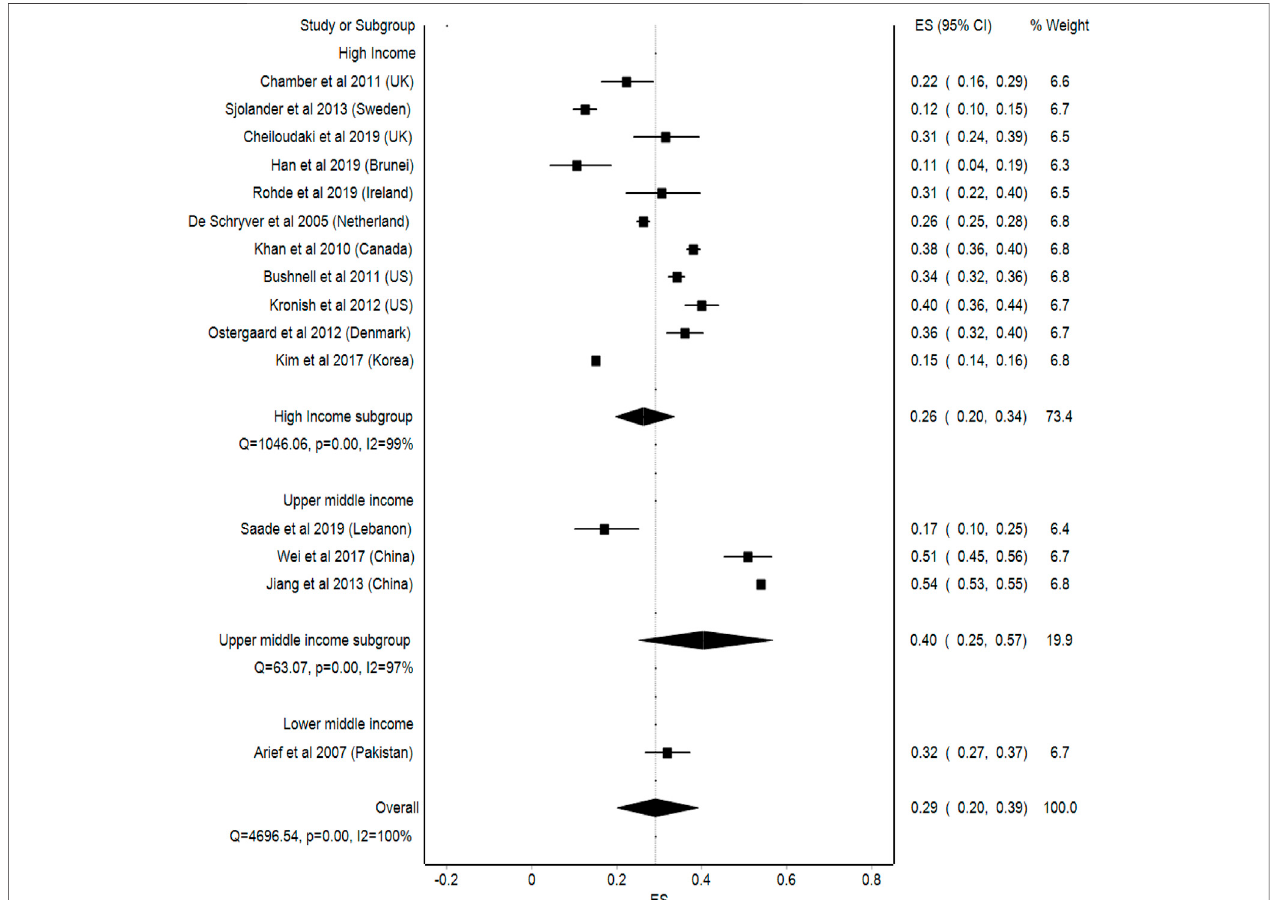
FIGURE 6 | Meta-analysis of medication non-adherence by level of